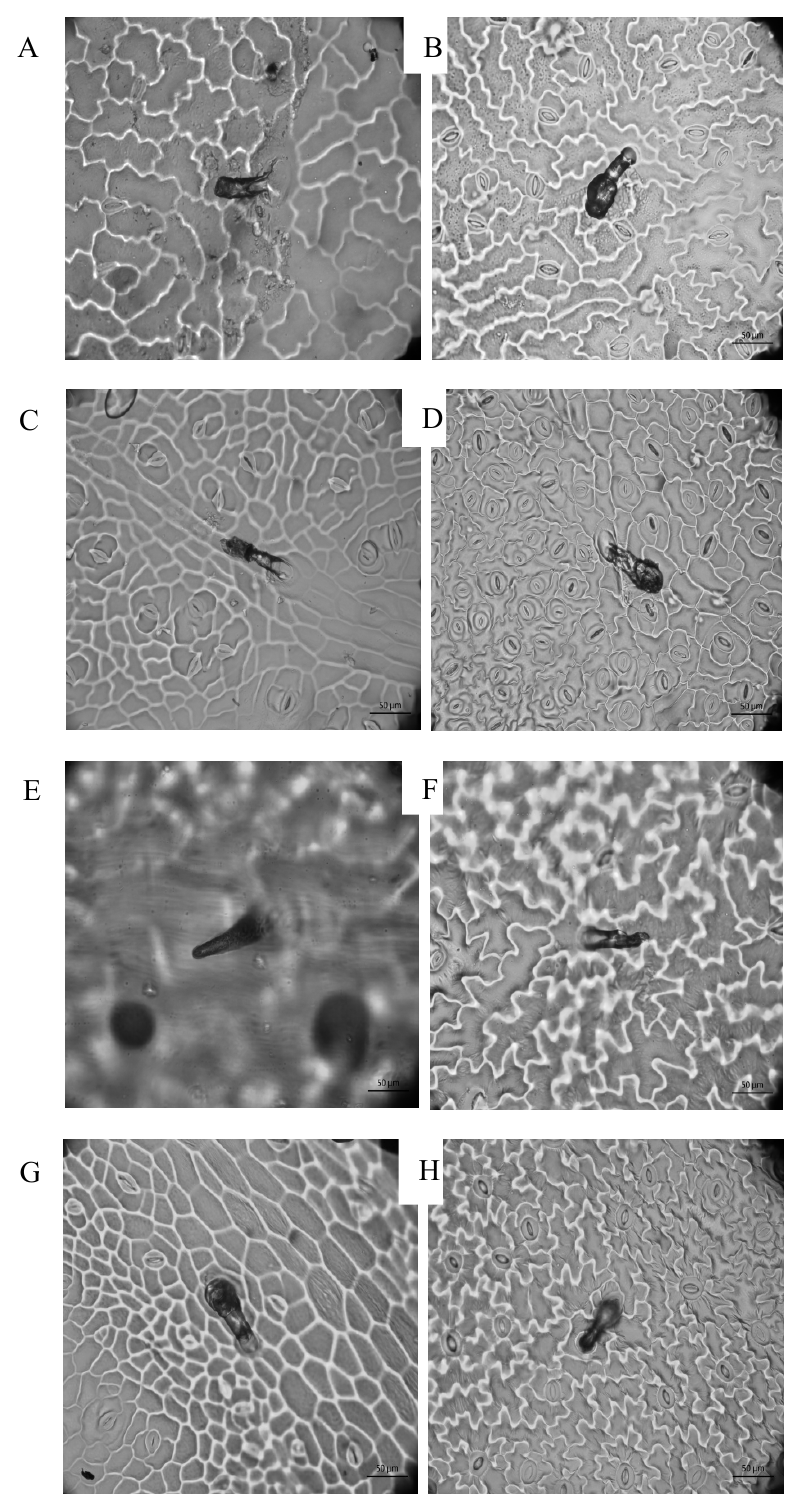
Figure 1. Epidermal cell imprints of domestic varieties (lower and upper sides) stomata and glandular trichomes in C and G. Chile de arbol ( A , B ), Güero ( C , D ), Jalapeño ( E , F ), and Pimiento ( G , H ) (40 × ). 2.2. Stomatal Density and Size of the Upper and Lower Epidermis The stomatal density of the lower and upper epidermises was significantly different between the chili plants (Table 2). The stomatal density of the lower epidermis differed between the wild population and two out of six cultivated varieties, YAHU and